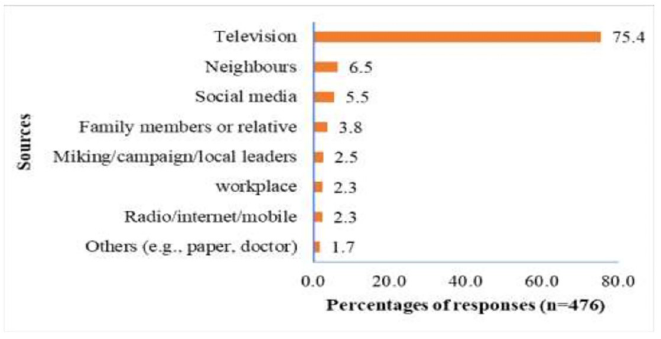
Fig 1. Sources of information on COVID-19 (in